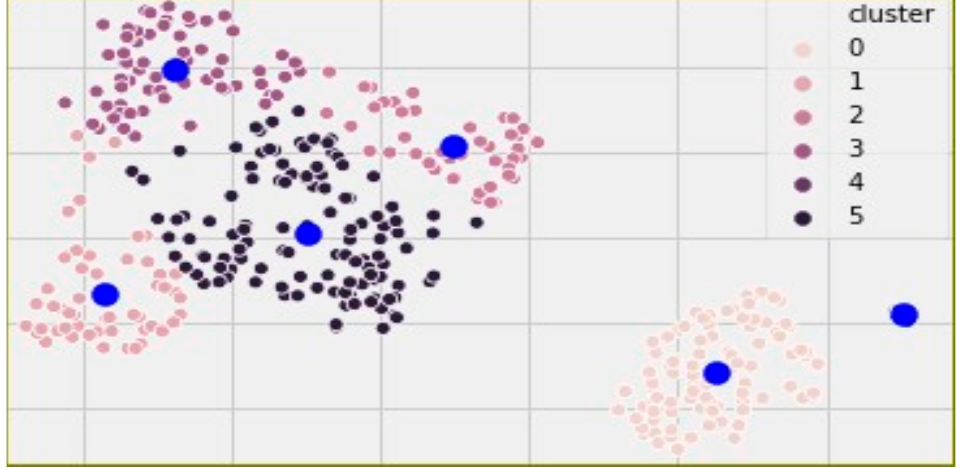
Figure 10. Cluster formation.